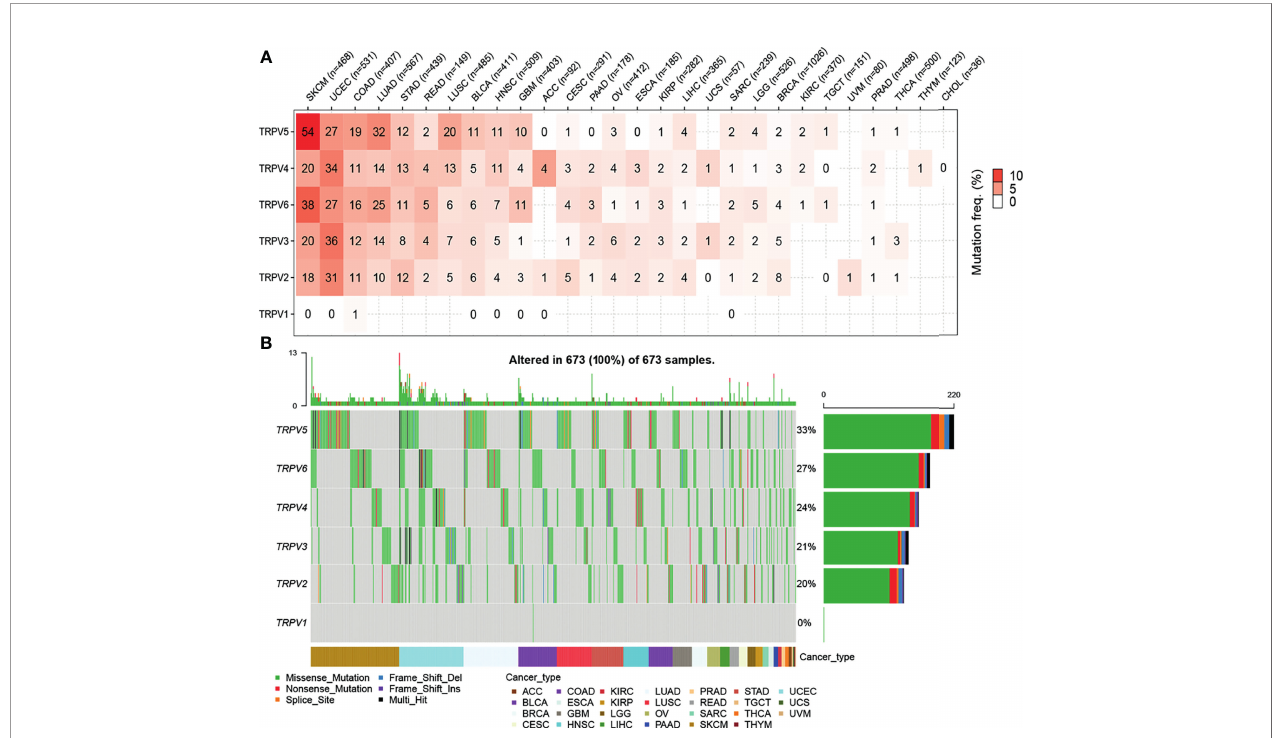
FIGURE 2 | Single nucleotide variation (SNV) frequency and variant mutation types of TRPV channels. (A) Mutation frequency of TRPV channels. Numbers represent the number of percentages that have the corresponding mutated gene for a given cancer. The number ‘ 0 ’ indicates that there was no mutation in the gene coding region, and the blank space indicates that there was no mutation in any region of the gene. (B) SNV waterfall plot showing the mutation distribution of TRPV channels and a classi fi cation of variant SNV